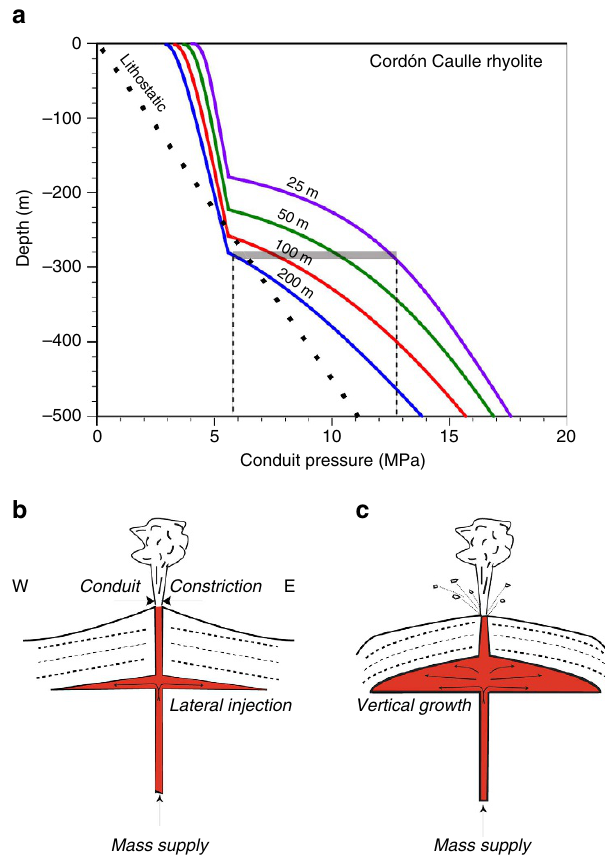
Figure 5 | Conduit overpressure as a mechanism to induce shallow intrusion. Conduit flow simulations 31 showing ( a ) magma pressure versus depth for the Cordo´n Caulle rhyolite. Lithostatic pressure gradient given as a bold-dashed line. Mass supply rates were in all cases 10 6 kgs (cid:2) 1 , a value informed by estimates derived from eruption plume of 8 June 2011 and related deposit characteristics 14,15 . Each model curve shows a different magma inlet–outlet radius configuration with the inlet radius held constant (200m) and outlet decreasing according to the numbers on each graph. Pressure increases as an approximate cube of conduit radius 31 and the characteristic ‘kink’ in the profiles reflect the fragmentation-induced transition from a bubbly magma to a gas-particle mixture, which in the CONFLOW 31 algorithm occurs at a critical magma porosity of 75%. Constriction of the outlet will cause pressurization of the conduit, in some cases up to ca. 7MPa (relative to the unrestricted outlet case) at 300m depth (horizontal grey band). ( b , c ) These images show schematic cartoons featuring the two key steps in syn-eruptive laccolith formation. Sill formation ( b ) must occur before the laccolith can inflate and deform overlying strata ( c